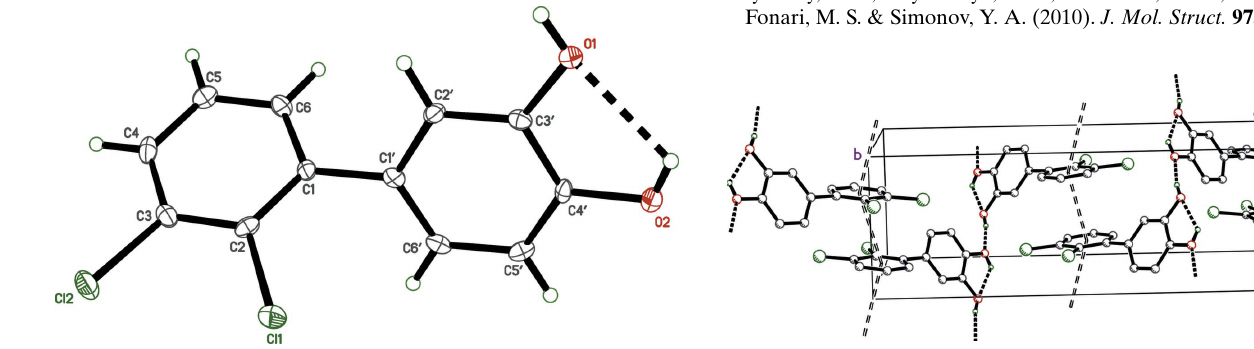
Figure 1 View of the title compound showing the atom-labelling scheme. Displacement ellipsoids are drawn at the 50% probability level. The intramolecular hydrogen bond (Table 1) is shown as a dashed